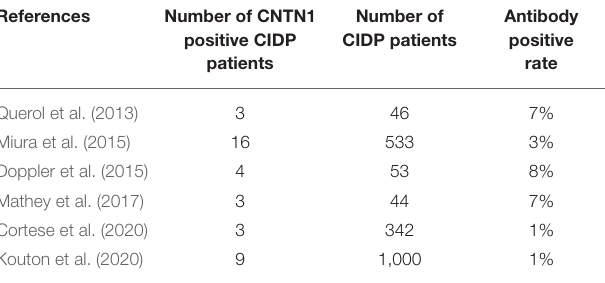
TABLE 3 | Percentage of CIDP patients with anti-CNTN1